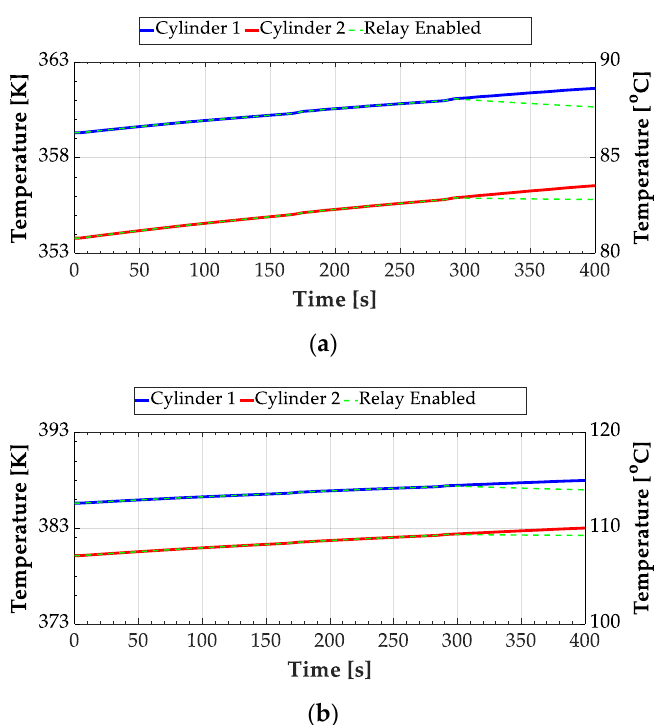
Figure 19. Temperature in the winding of the dry-type air-core reactor in filter 3. ( a ) Without including the effect of solar irradiance; ( b ) including the effect of solar irradiance.